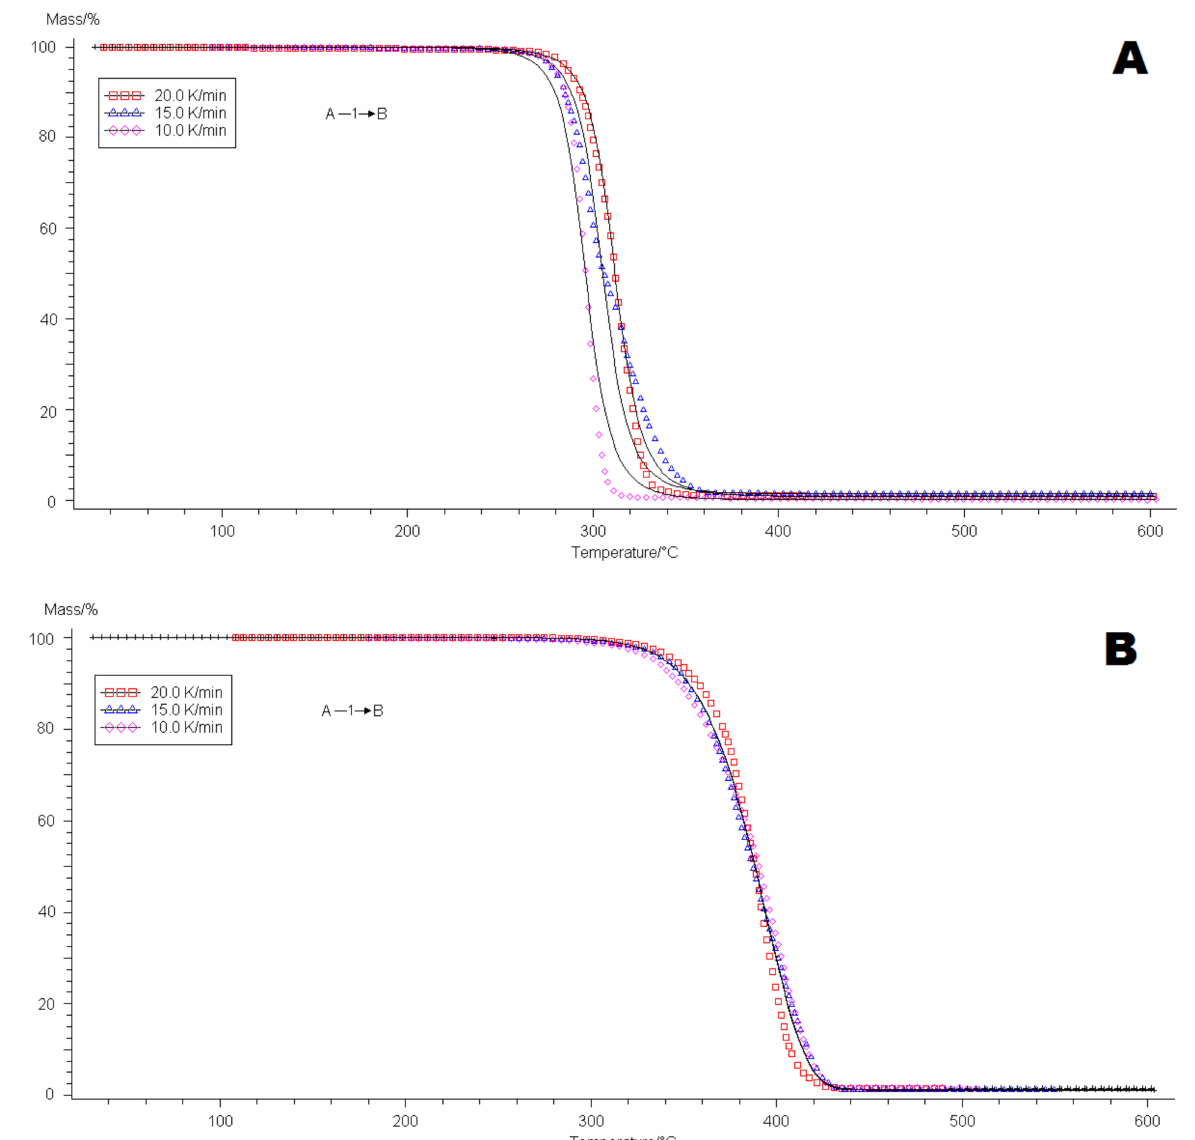
Figure A8. Experimental points for POM-R sample, investigated with 10, 15, and 20 ◦ C/min heating rates, represented by simulated solid lines: ( A ) investigations carried out in oxygen atmosphere; ( B ) investigations carried out in inert atmosphere. For the simulation, the apparent activation energy was used as the function of